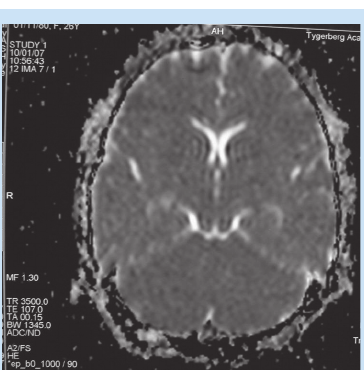
Fig. 1e. Corresponding calculated ADC map.